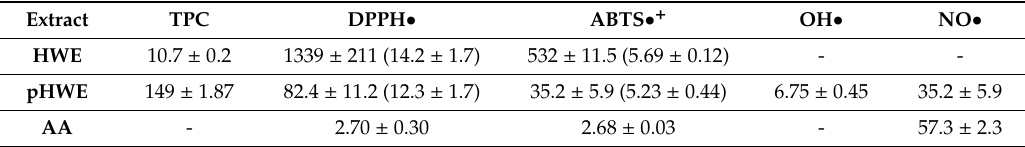
Table 3. Total polyphenolic content (TPC) and antioxidant (DPPH • , ABTS • + , OH • , NO • ) activity of the hot water extract before (HWE) and after the purification